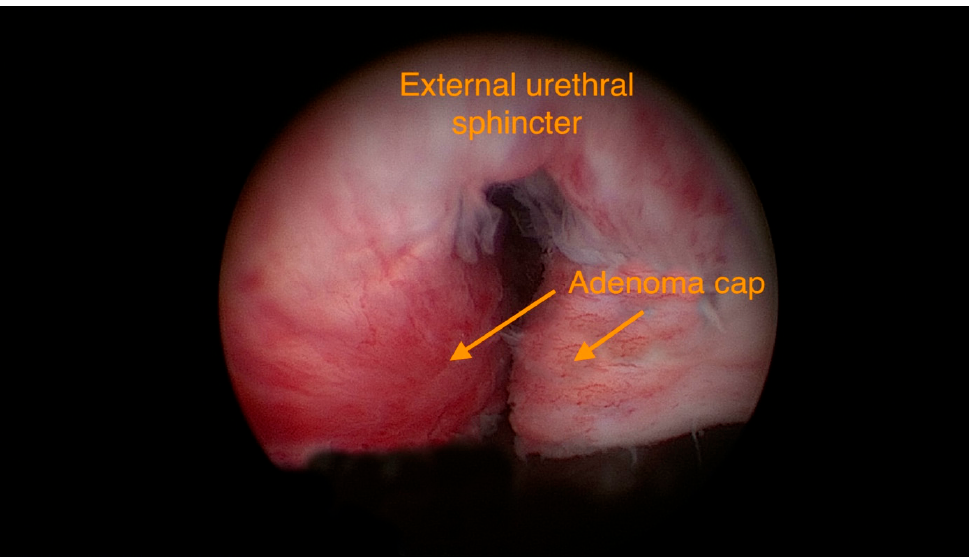
Figure 6. Final result: endoscopic view.